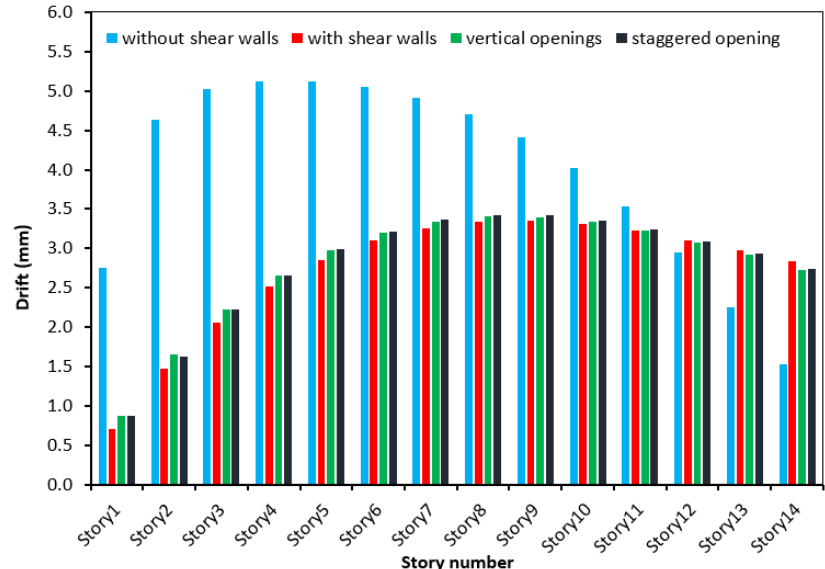
Figure 13. Story drift of the models: static analysis and X-direction analysis.